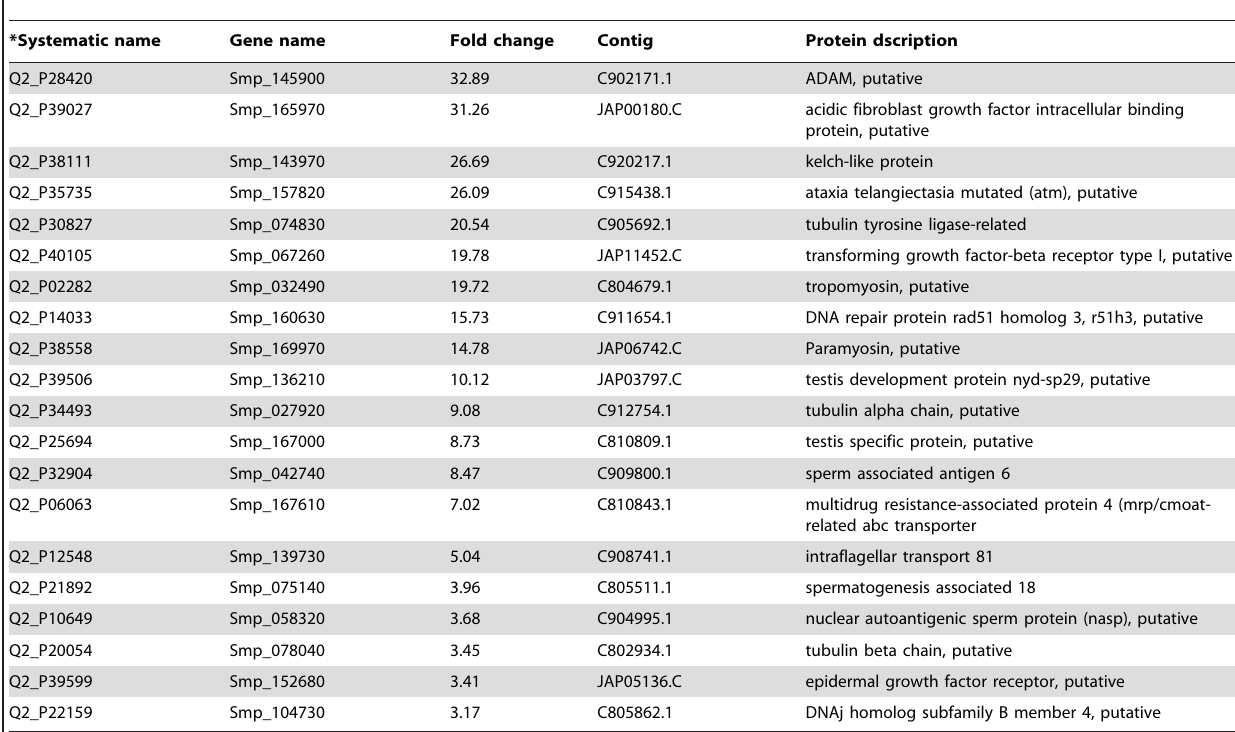
Table 4. A selection of differentially up-regulated genes of testis normalised to the whole male